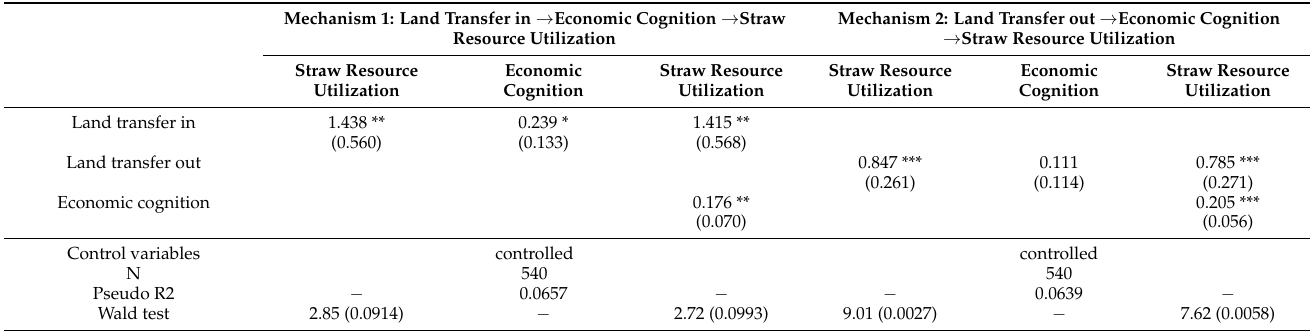
Table 6. Analysis of the intermediary mechanism of economic cognition.